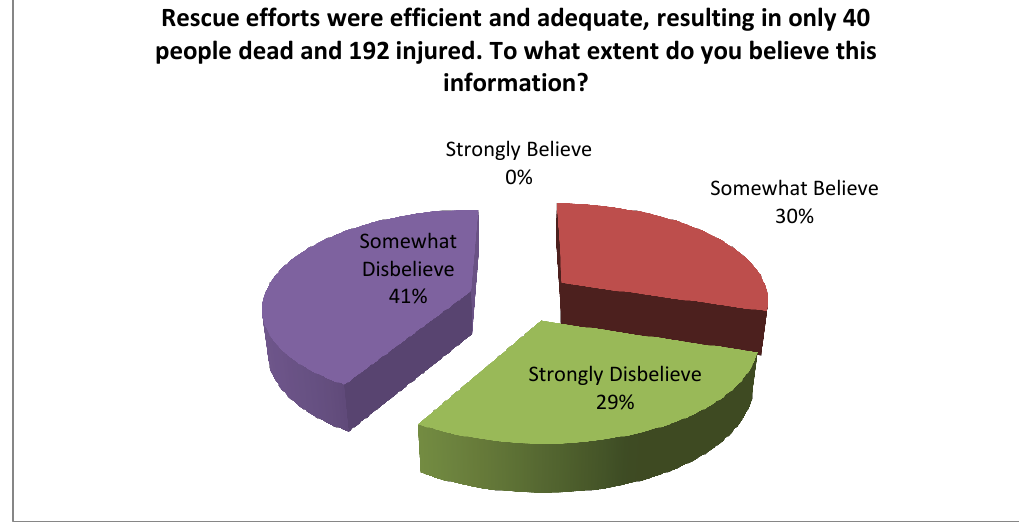
Figure 1: Trust / distrust in positive information about Wenzhou train collision